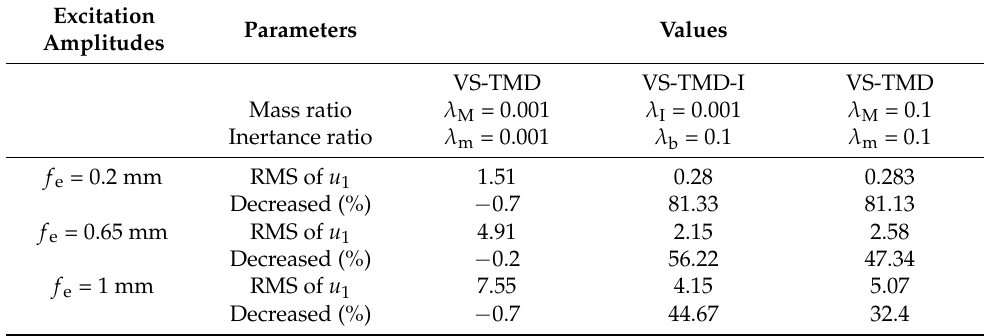
Figure 3. Vibration reduction performance with different mass ratios and inertance ratios under different displacement excitations: ( a ) f e = 0.2 mm; ( b ) f e = 0.65 mm; ( c ) f e = 1 mm. Table 2. Dimensionless parameters of the primary structure and the VS-TMD-I.